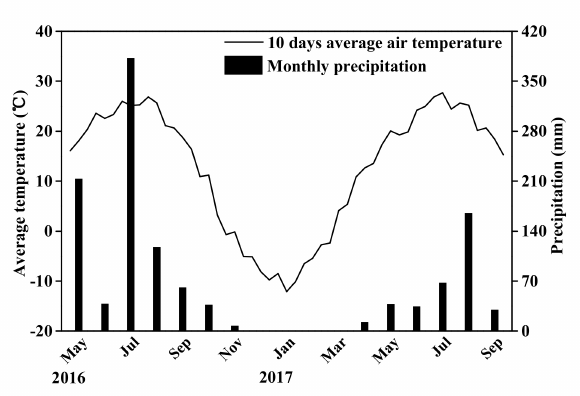
Figure 1. Monthly precipitation (mm) and ten days average air temperature ( ◦ C) from May 2016 to September